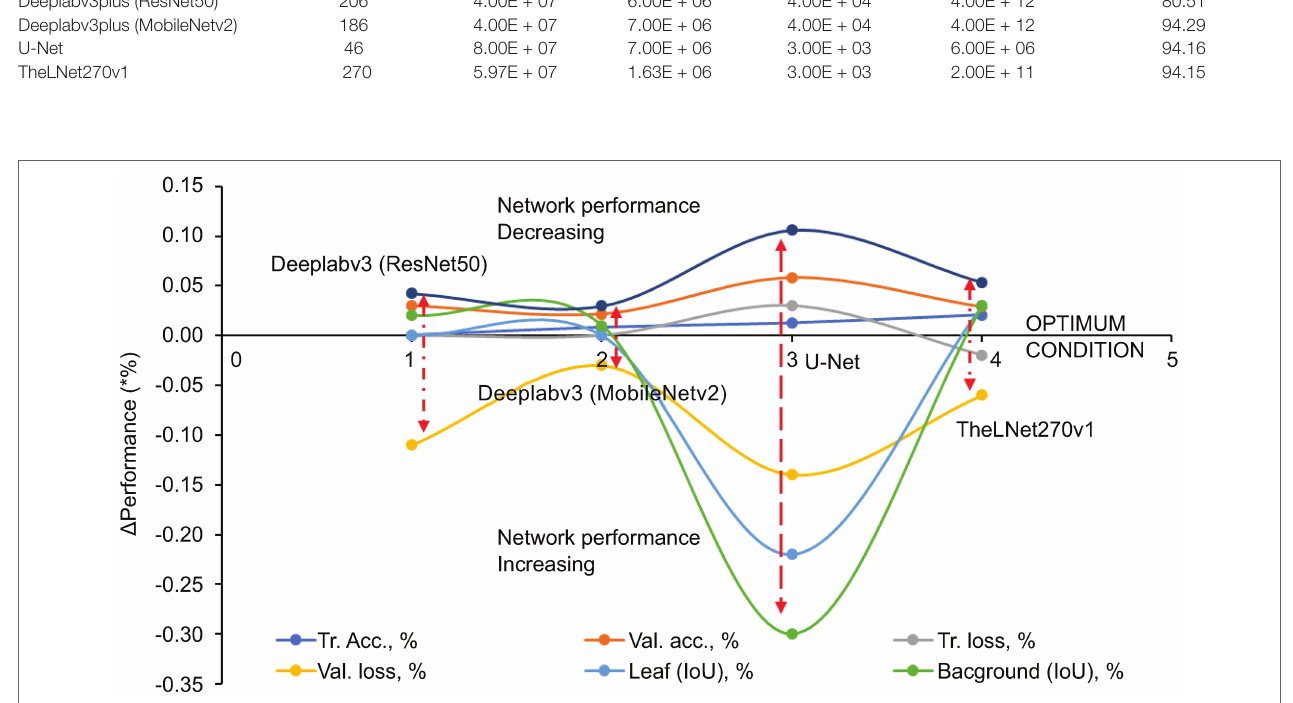
FIGURE 12 | Δ Performance of the evaluation metrics.